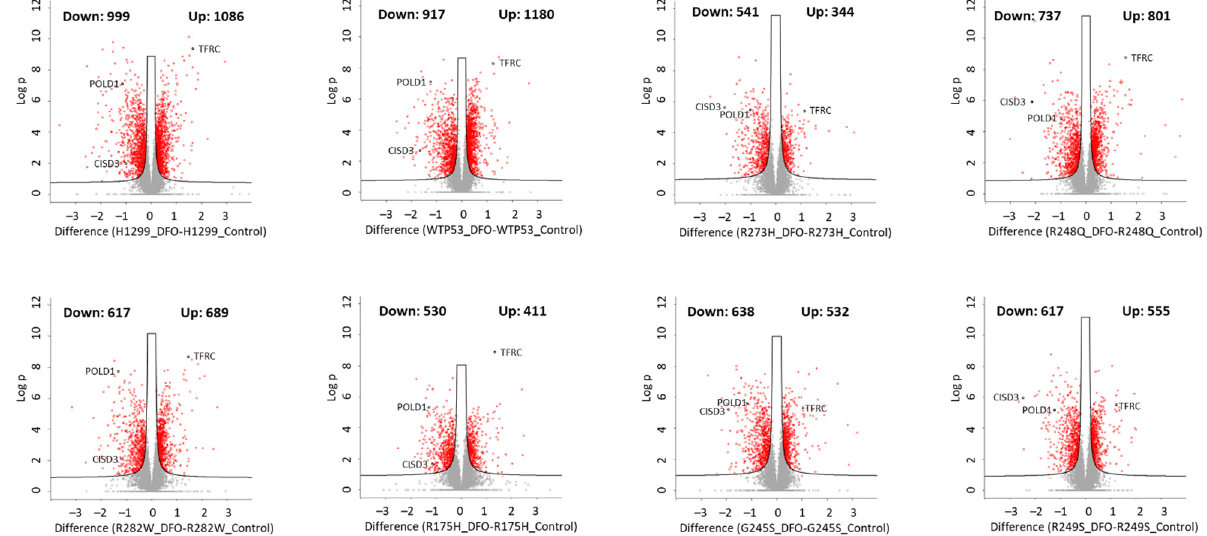
Figure 2. The influence of iron chelation on the mutant TP53 proteome. Volcano plots summarizing significantly ( q < 0.05) downregulated and upregulated proteins in TP53 null H1299 cells, or H1299 cells expressing WT TP53, or a representative “hotspot” TP53 mutation type treated ± DFO (50 µM, 48 h).